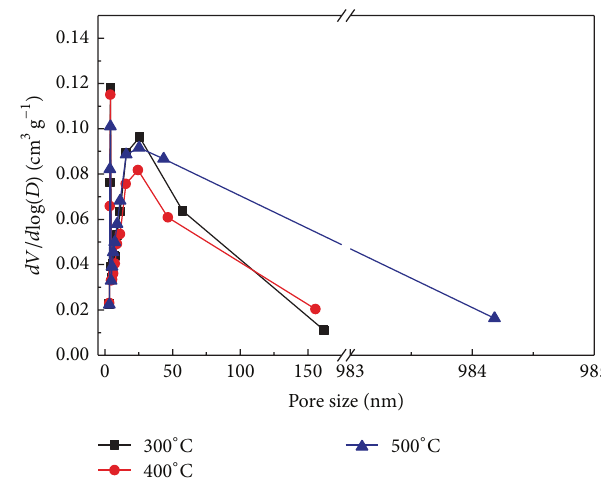
Figure 6: Pore diameter distribution of catalysts under different calcination